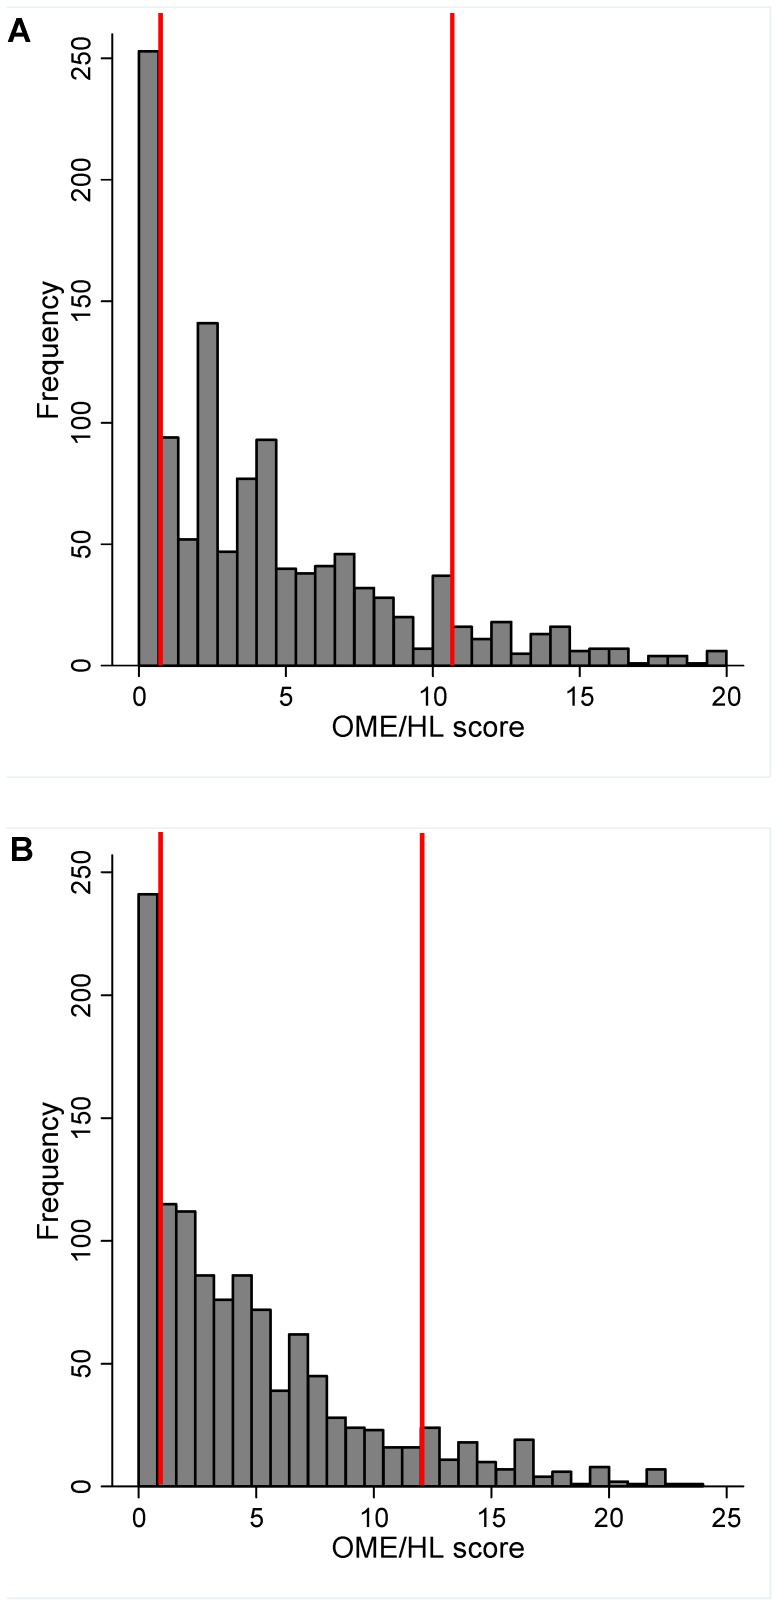
Distribution of the prorated OME/HL score and the OME/HL groups.A) At four years (maximum score 20). B) At five years (maximum score 24). The cut-off points defining the unaffected (score of zero), intermediate and highest 10% groups are shown.